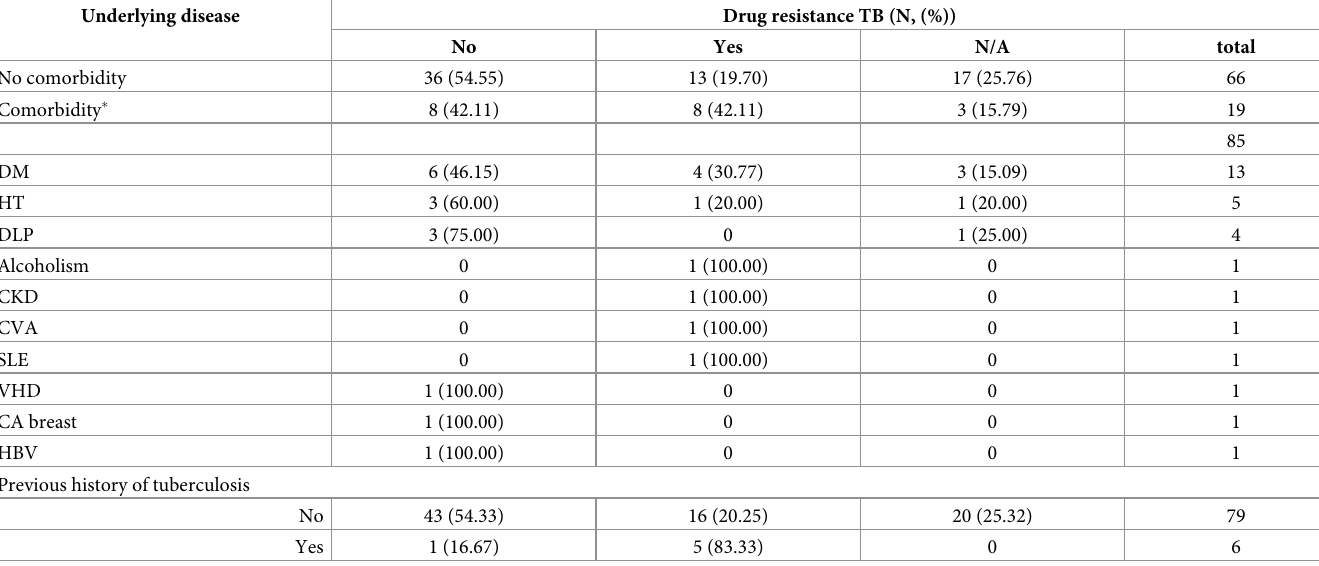
Table 2. Underlying diseases and drug resistant patterns of TB disease in HCWs at KCMH from 2012–2020. Underlying